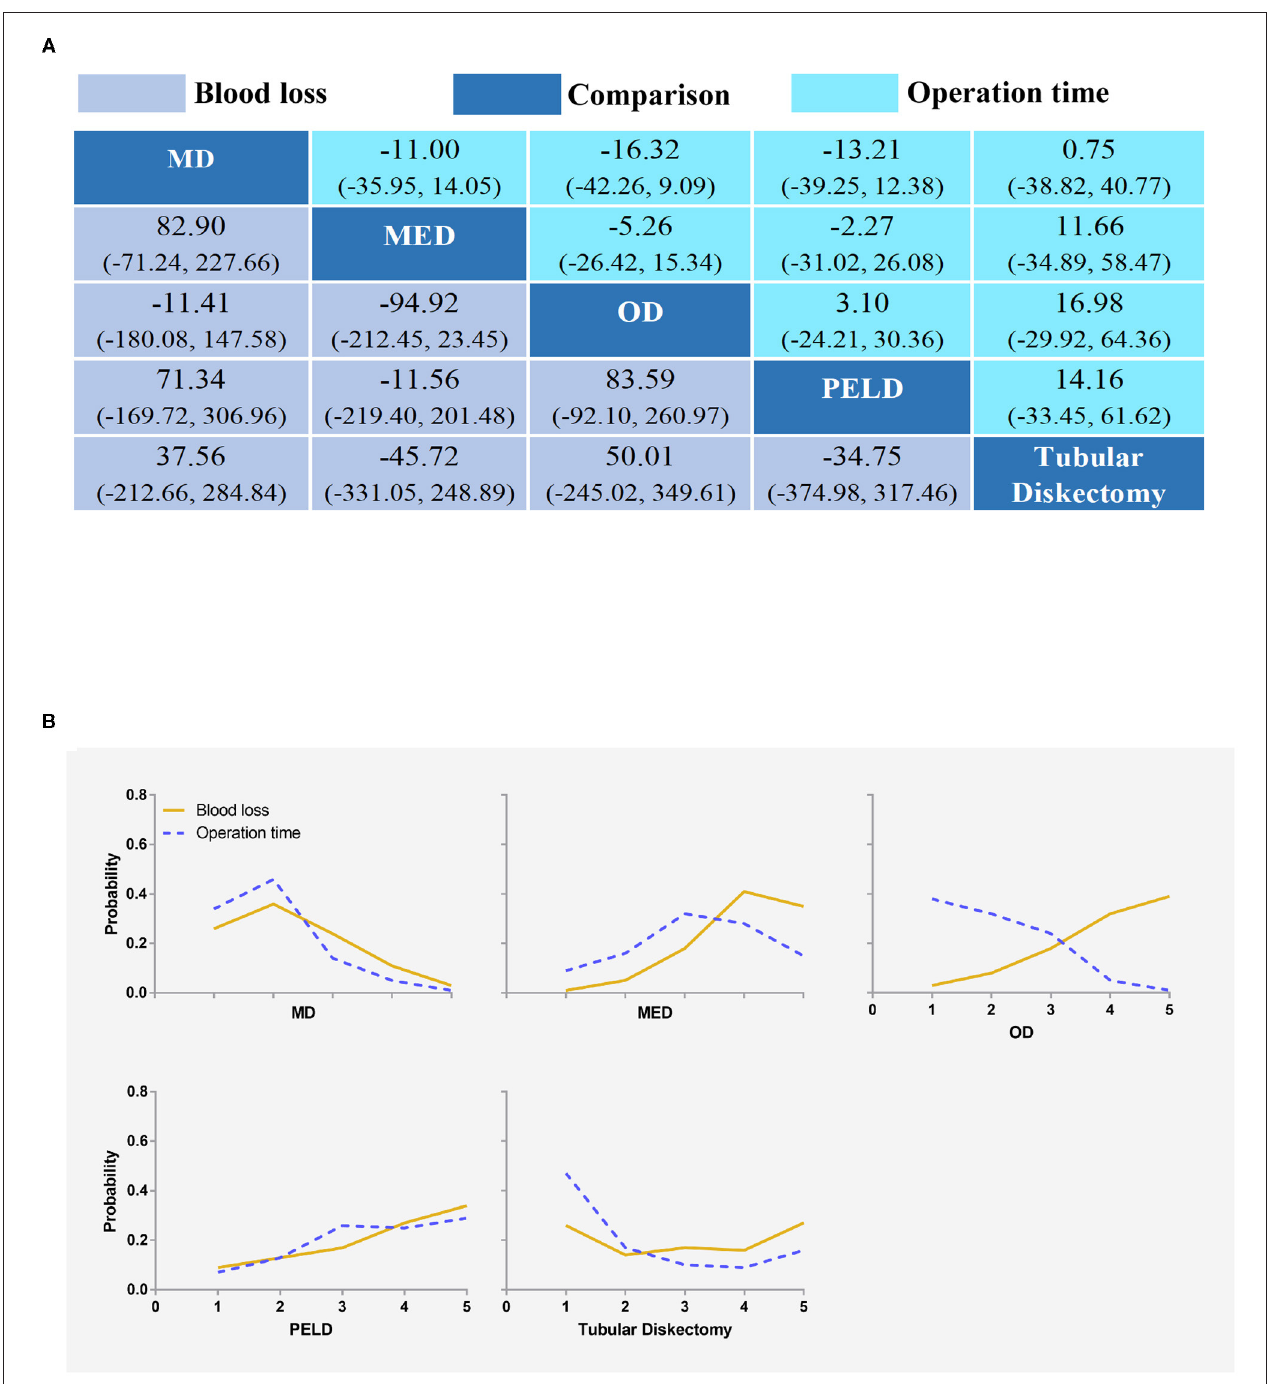
FIGURE 5 | Blood loss and operation time (A) and the rank possibility of blood loss and operation time (B) based on NMA in the consistency model. Each cell of the profile contained the pooled mean difference and 95% credibility intervals for disability change; significant results are in bold. MD, Microdiscectomy; MED, Micro-endoscopic discectomy; OD, Open discectomy; PELD, Percutaneous endoscopic lumbar discectomy.